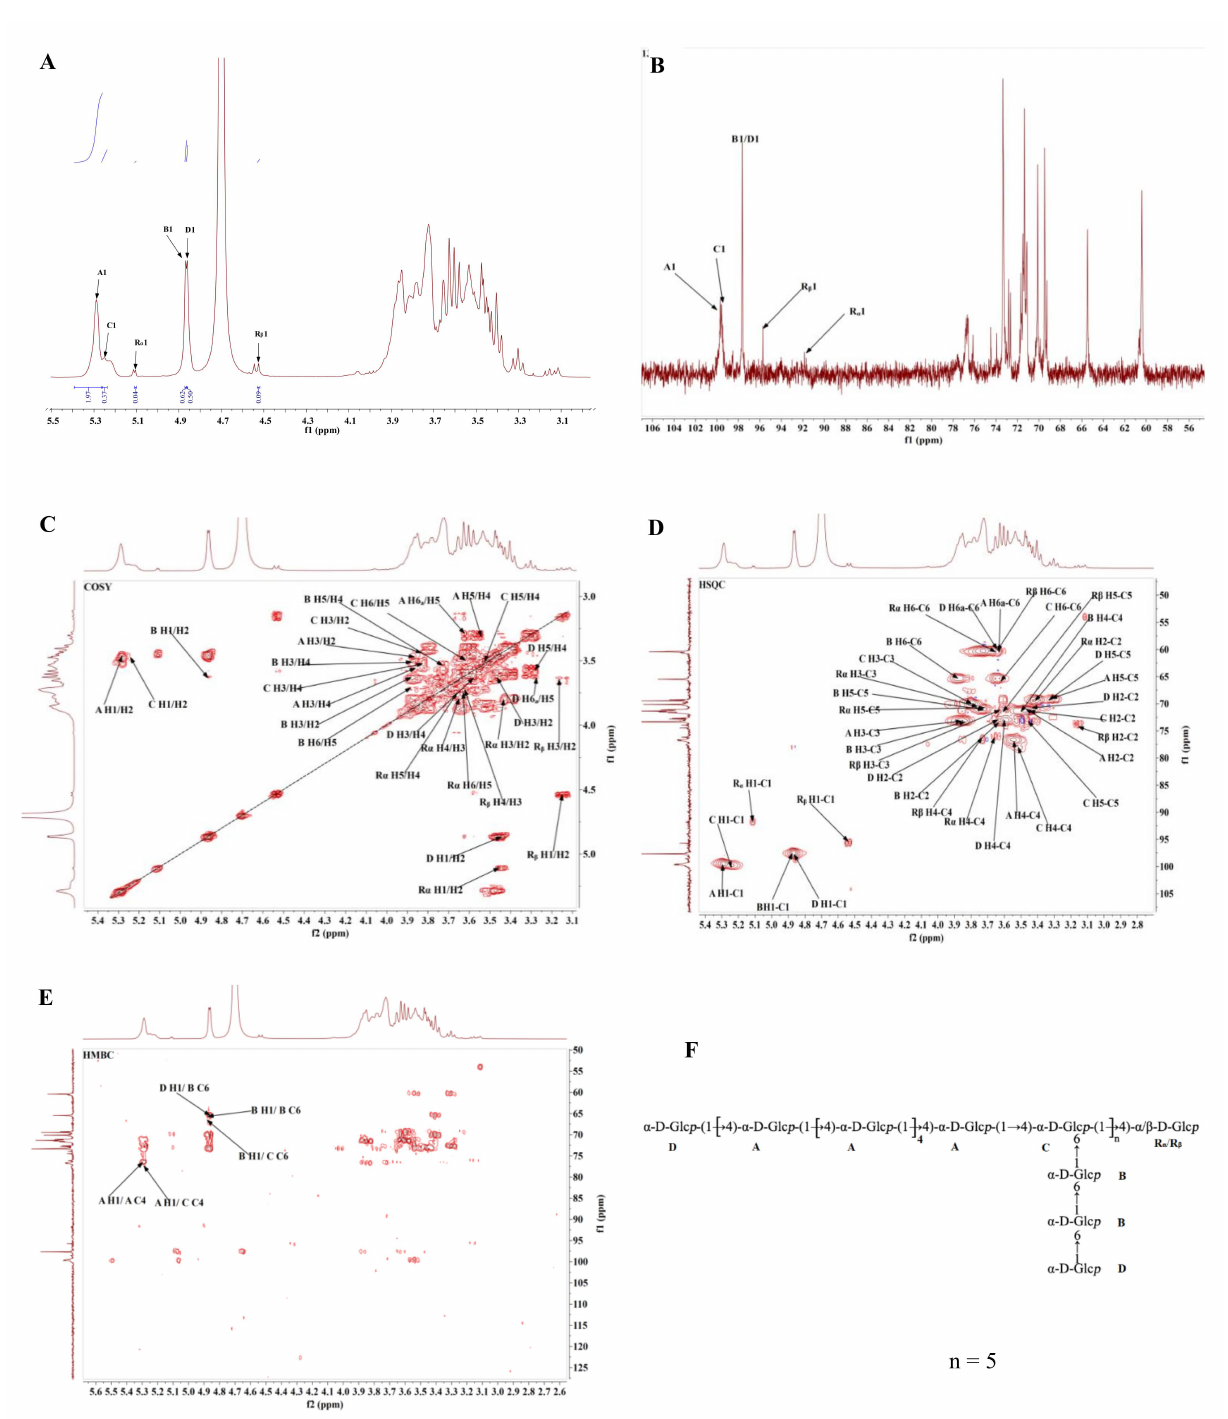
Figure 4. 1 H spectrum ( A ), 13 C spectrum ( B ), COSY spectrum ( C ), HSQC spectrum ( D ), HMBC spectrum ( E ), and predicted repeating unit of NPPc ( F